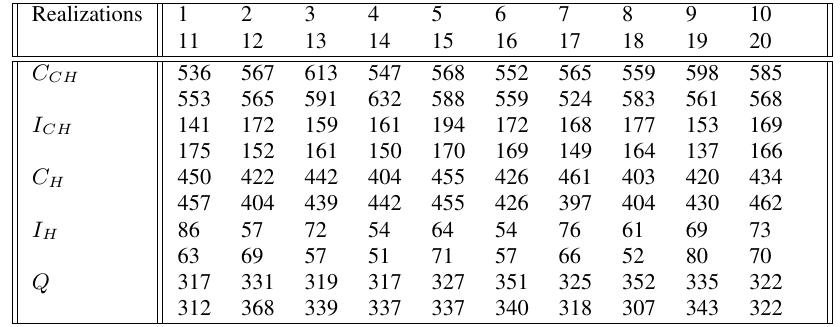
tial rank correlation coefficient (PRCC) method. The LHS stratifies parameters sample space based on the ranges given in Table II and then sample from these space without replacement. Using re- sponse functions the reproduction number ( R HC ), the prevalence of CA-and HA-MRSA among pa- tients and healthcare workers and the hospital environment, a total of 1,000 simulations of the model (2.1) per LHS run were then carried out and the outcome ranked using PRCC. From Figure 2 and Table III, we conclude that the prevalence of MRSA was the lowest when the rates for hand washing compliance and the bacterial decay were at their highest values. Consequently, the prevalence would increase when the environmental contamination and the transmission rates were high. In the stochastic framework, we considered a continuous-time Markov chain and assumed the number of health-care workers to be constant. The stochastic process of model (2.1) is shown to be positive recurrent. Using the transitions from the deterministic model (2.1), we derived the instan- taneous transition rates for our stochastic model. Numerical simulations of the stochastic model dis- played similar results to the deterministic model. We observed an interesting, nonlinear relationship among the prevalence of MRSA among hospital patients and the intervention parameters ( η , τ W , ω ω CCH , and CH